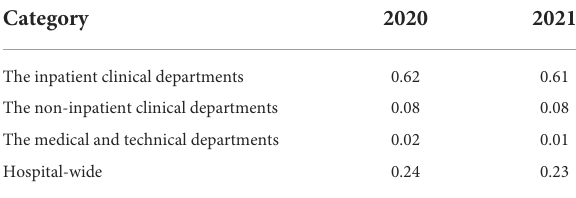
TABLE 6 The average monthly per capital score of clinical departments in the inpatient department in 2020 and 2021